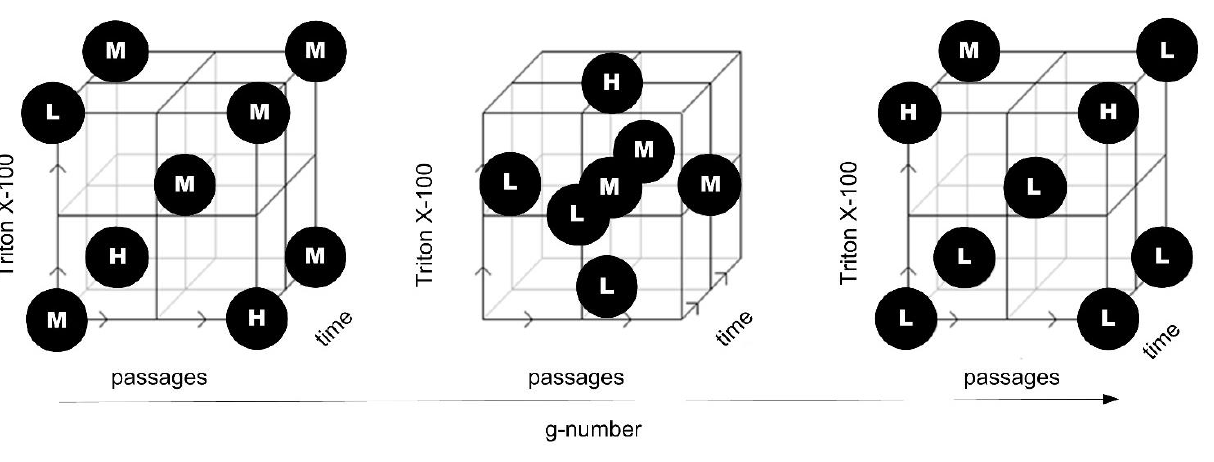
Figure 5. Central composite face centered design for DoE across unit operations. Parameter passages from unit operation homogenization, Triton X-100 concentration from washing step, and time plus g-number of the unit operation centrifugation are combined in this design space exploration; H = high, M = middle and L = low level of